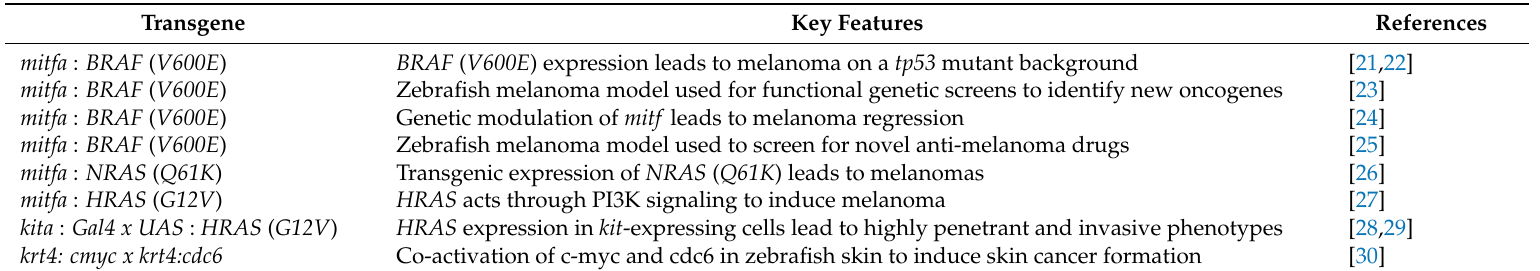
Table 1. Development and applications of melanoma skin cancer models in zebrafish using transgenic tools.